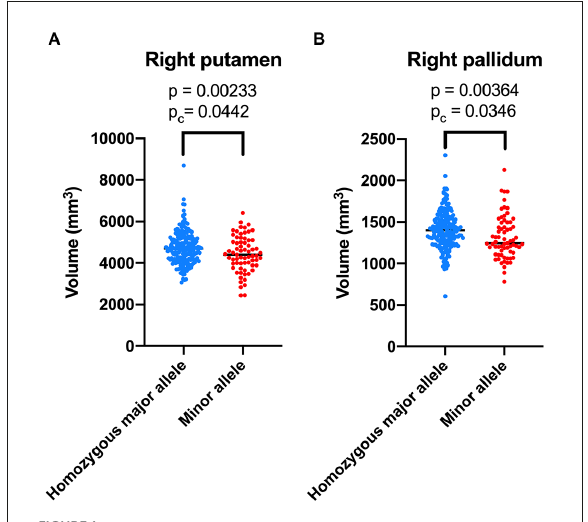
FIGURE1 Volumetric comparison of the right putamen (A) and right pallidum (B) between the homozygous major allele carriers and minor allele carriers of